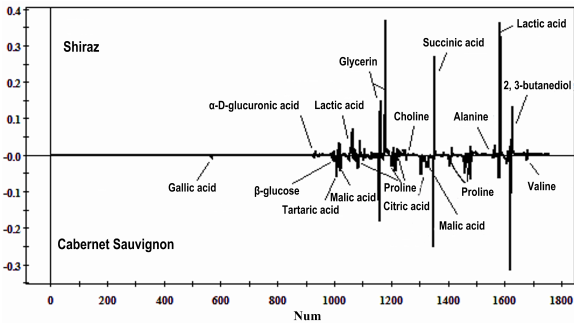
Figure 5: PLS-DA loading plot based on the 1 H NMR spectra of Cabernet Sauvignon and Shiraz dry red wines.